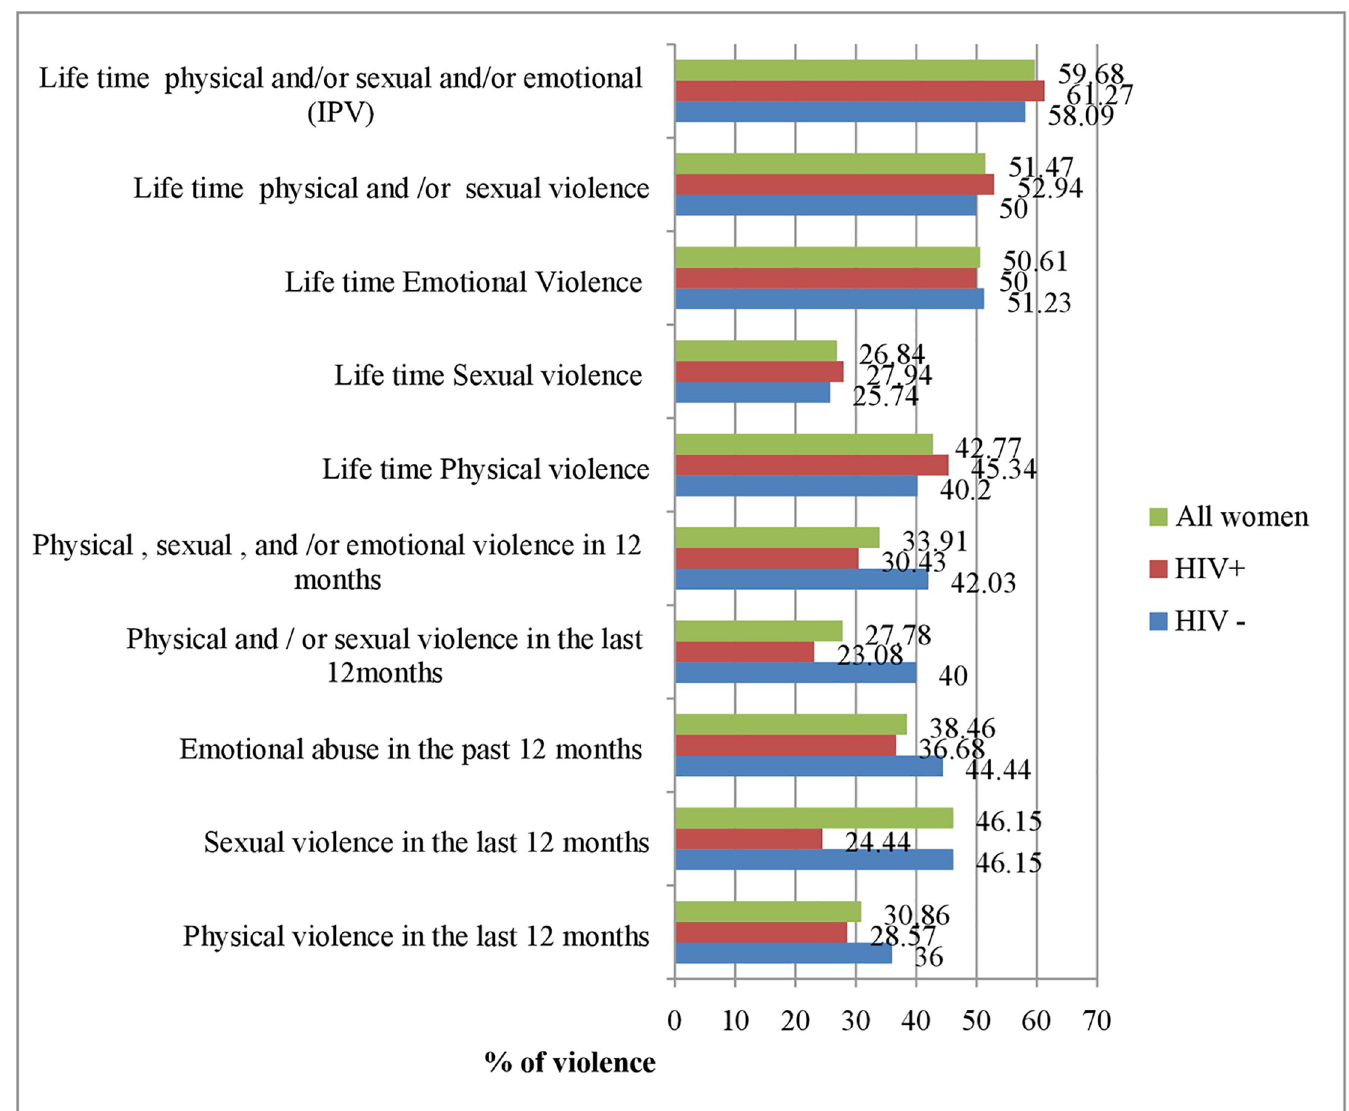
Fig 2. Prevalence of intimate partner violence in Wolaita Zone, Ethiopia, November-December 2018.